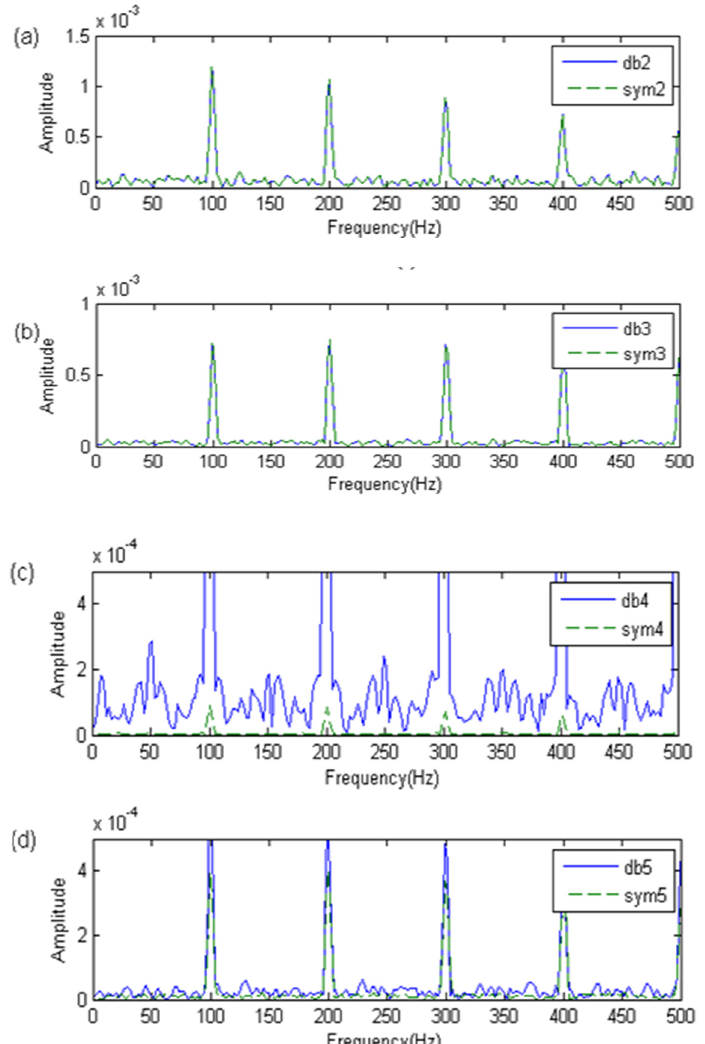
Figure 4. The results of the envelope analysis: ( a ) db2,sym2; ( b ) db3,sym3; ( c ) db4,sym4; ( d ) db5,sym5.